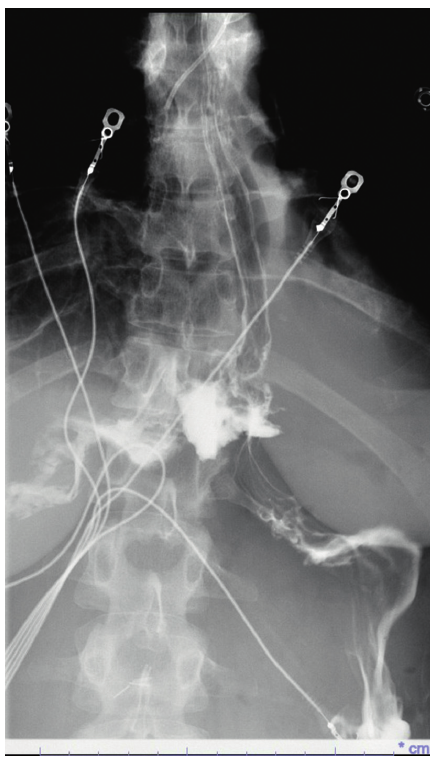
Figure 2: Esophagogram: esophageal perforation with contrast extravasation at the approximate level of the gastroesophageal